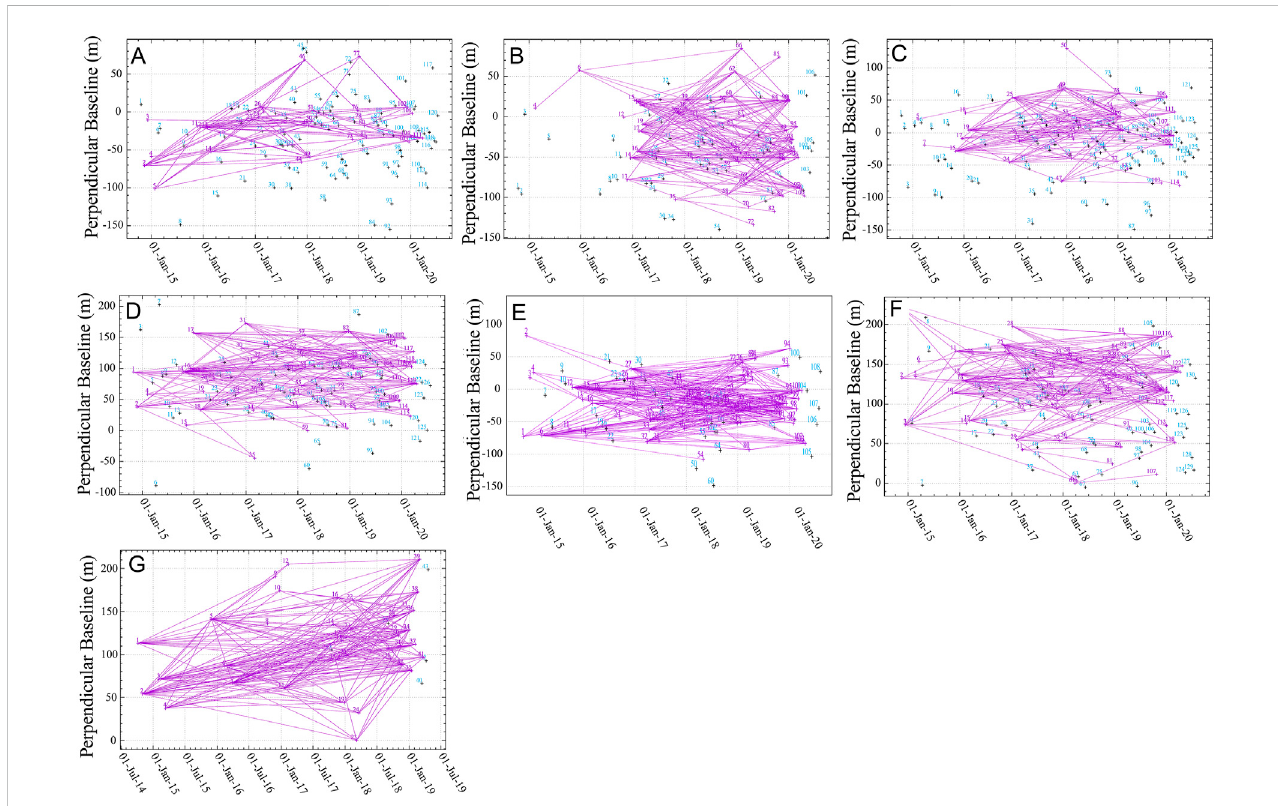
FIGURE 3 Distribution of temporal and spatial baselines of interferograms for tracks (A) A70, (B) A172, (C) A99, (D) D77, (E) D4, (F) D106, and (G) D33. The crosses with purple labels denote images used for velocity calculation, whereas the crosses with cyan labels represent other images. The purple lines indicate the generated